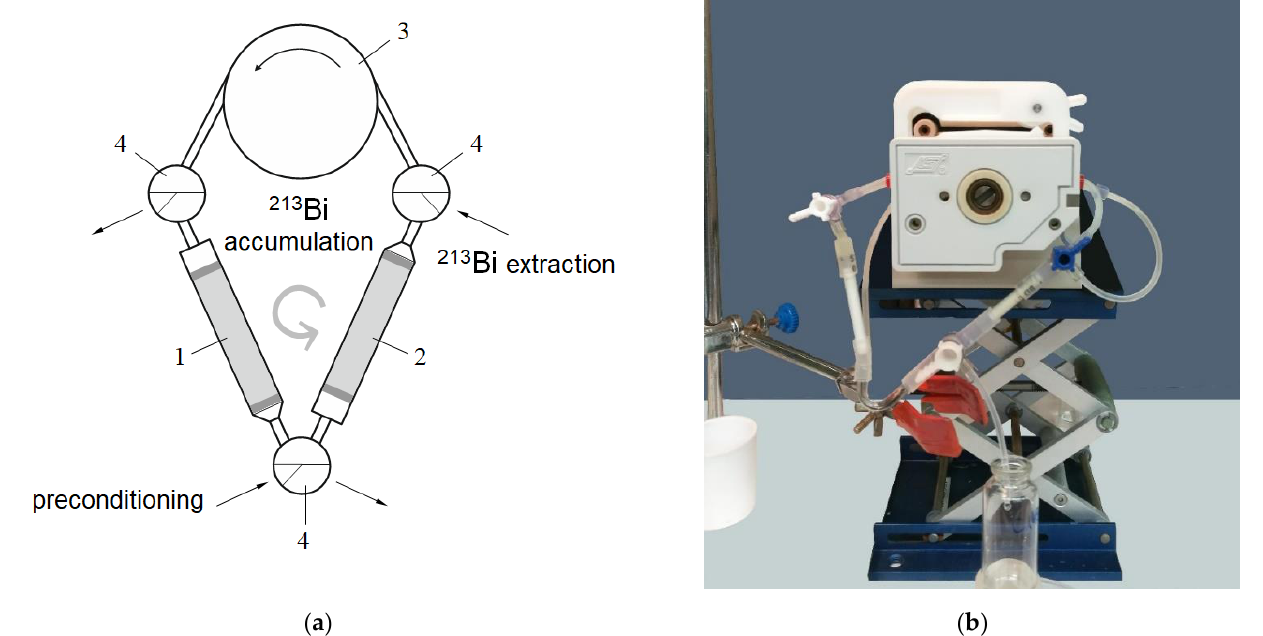
Figure 1. Scheme ( a ) and photo ( b ) of a laboratory 225 Ас/ 213 Bi generator “Afrabis”. 1—chromatographic column with parent 225 Ac; 2—chromatographic column for 213 Bi accumulation; 3—peristaltic pump; 4—three-way cock.